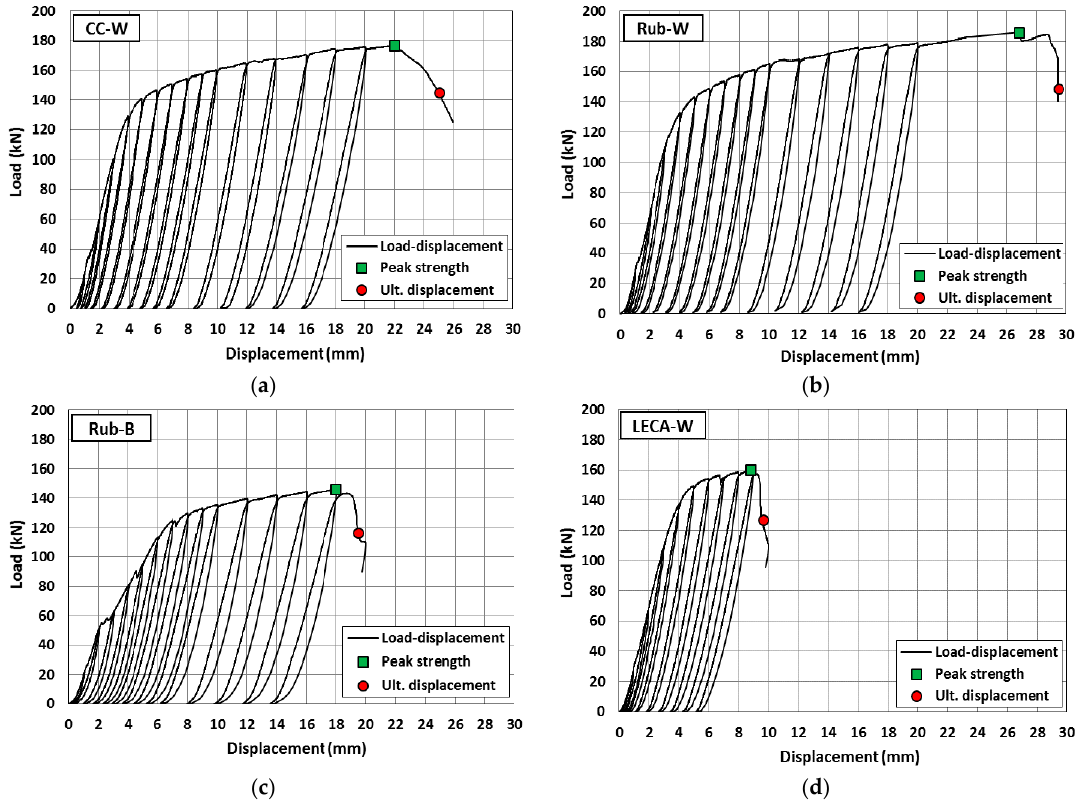
Figure 6. Cyclic behavior for tested specimens: ( a ) CC-W, ( b ) Rub-W, ( c ) Rub-B, and ( d ) LECA-W.